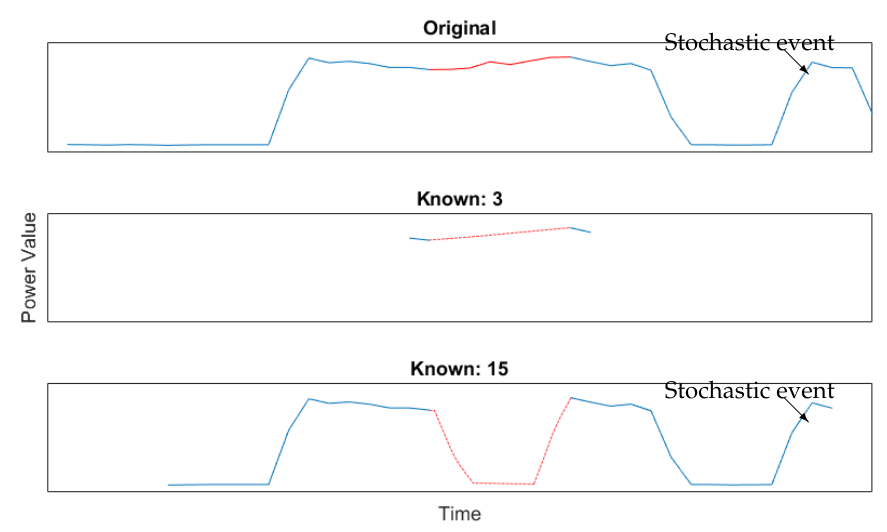
Figure 7. Stochastic effect on prediction.